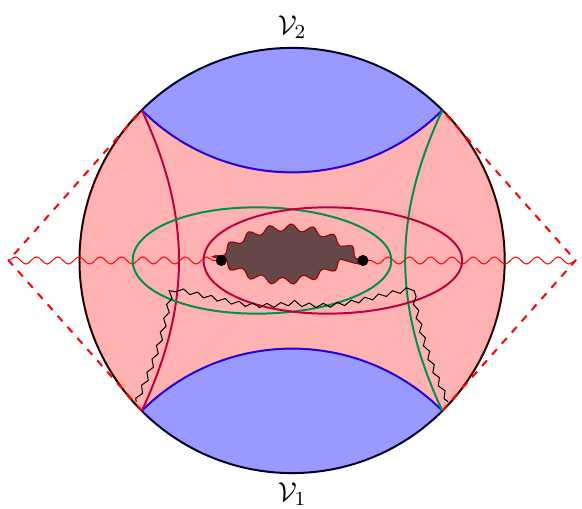
Figure 18. This figure illustrates a contradiction that would arise if more than one dividing curve intersected the closed curves wrapping a singularity. The black zigzag curve in this figure lies in ) ∩ J − ( E ) only at a single set of points, which contradicts the lemma that there exists J − ( E W W 2 1 an open family of curves on F connecting E to E V 1 V 2